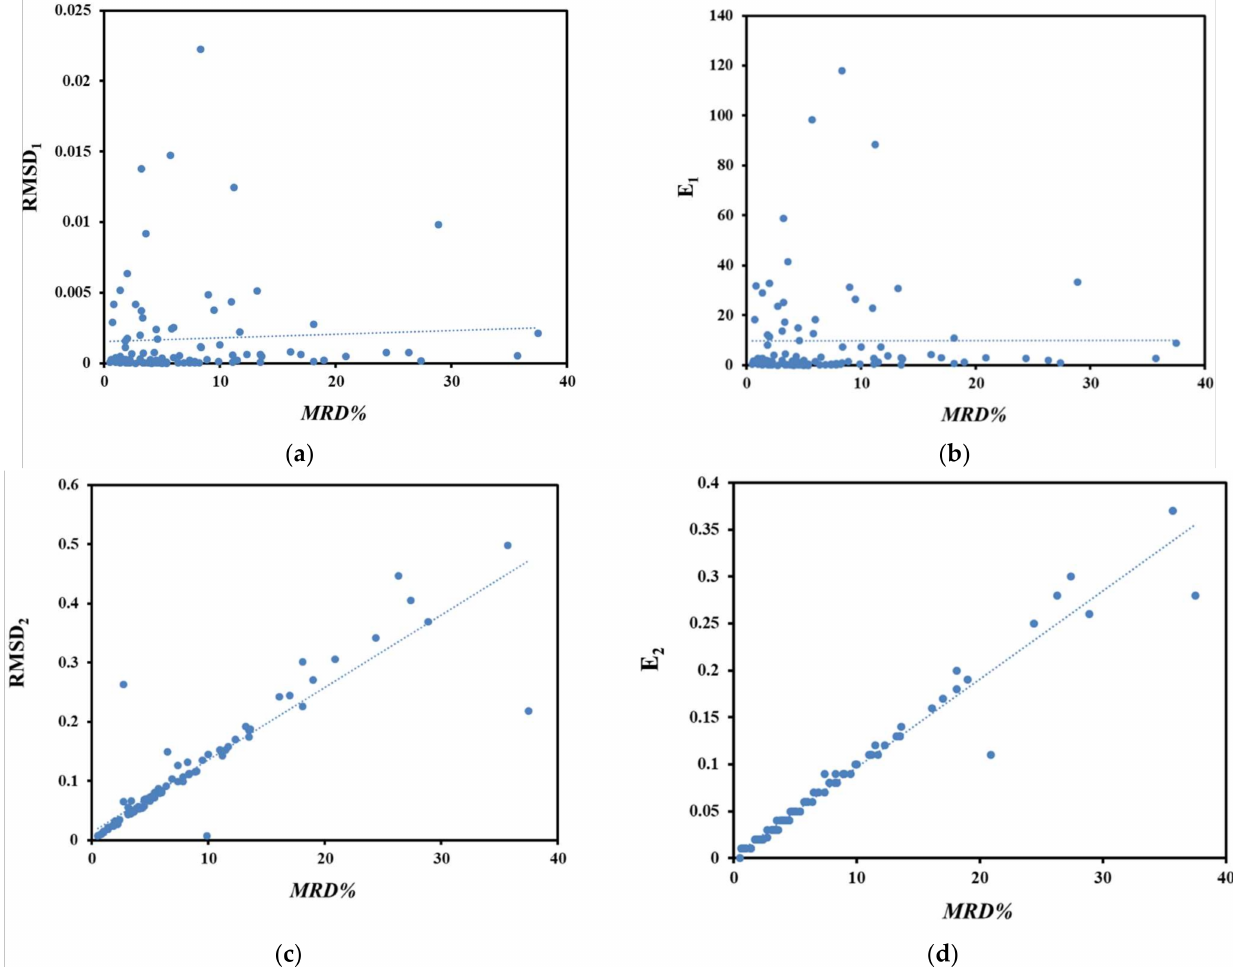
Figure 2. Correlations between various error criteria with the MRD% values for back-calculated data with Equation (1); ( a ) RMSD 1 vs. MRD% , ( b ) E 1 vs. MRD% , ( c ) RMSD 2 vs. MRD% and ( d ) E 2 vs. MRD%